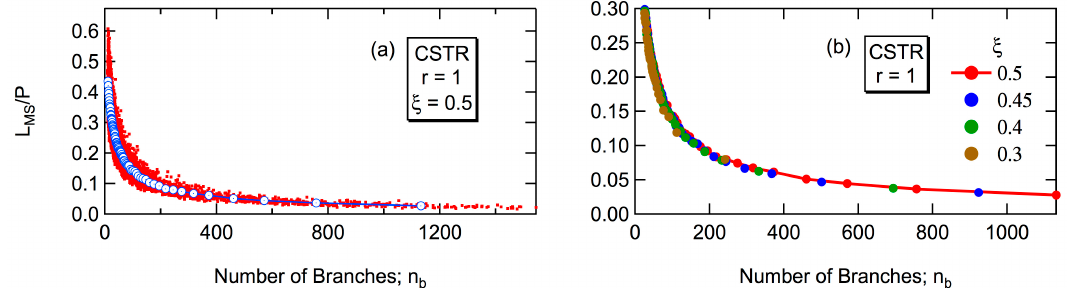
Figure 23. Relationship between L MS / P and n b for a CSTR with r = 1. ( a ) Each data point (red) and the expected L MS / P (blue), at ξ = 0.5. ( b ) The expected L MS / P for the HB polymers having n b branch points in a polymer with ξ = 0.5, 0.45, 0.4, and 0.3.